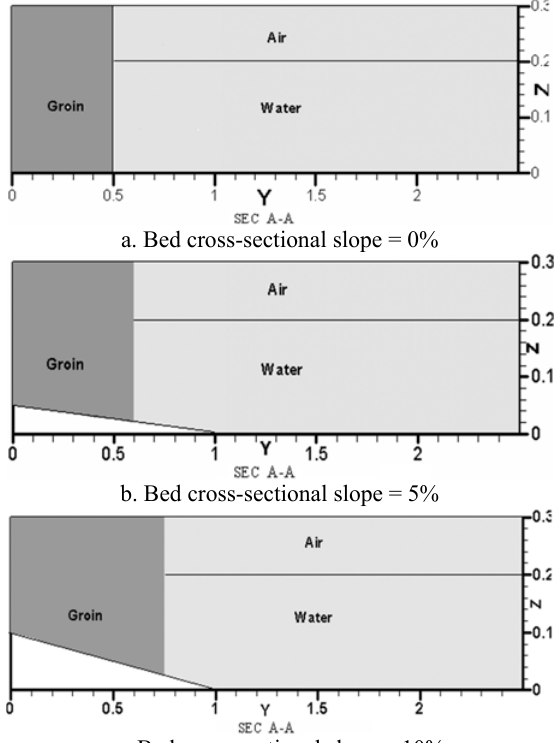
Fig.6 Geometry shapes of cross-sectional for the groyne with sidewall slope =